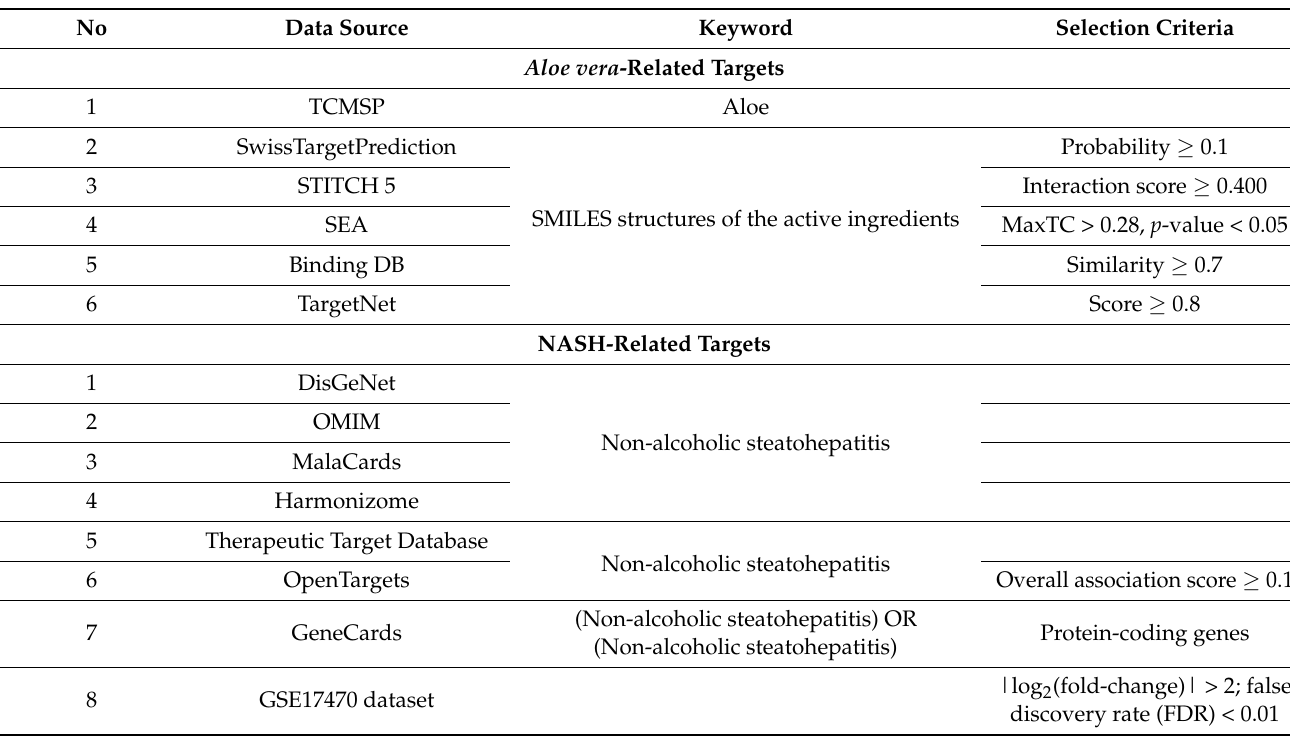
Table 3. Data sources and selection criteria for target